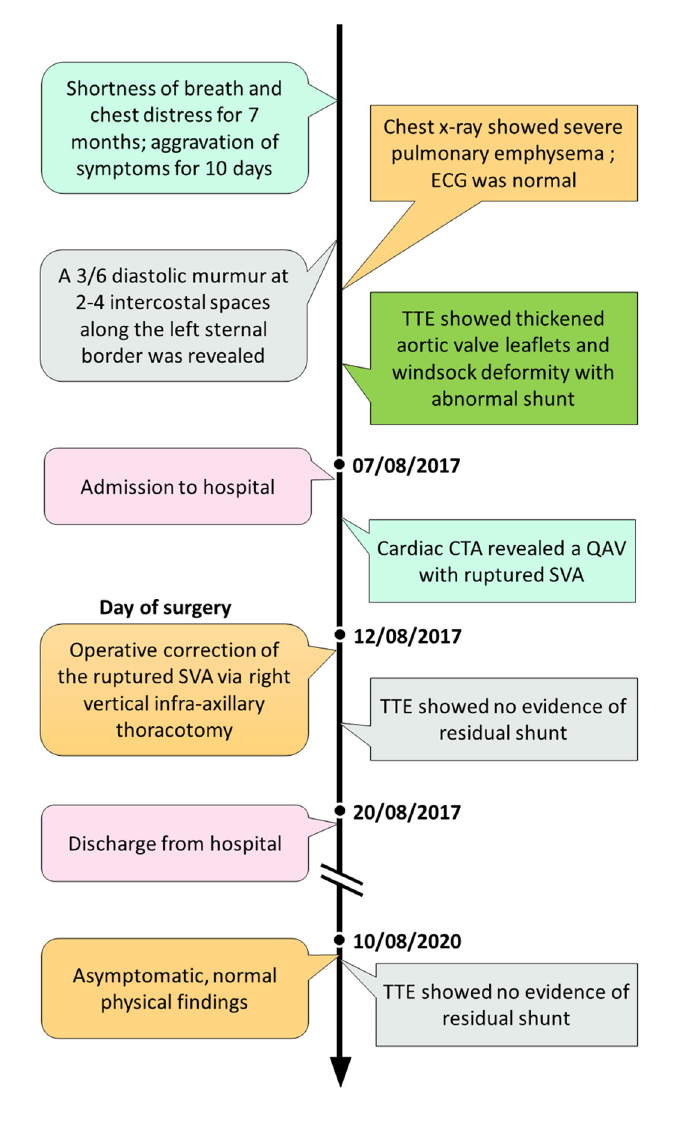
Fig. 3 - Timeline of the diagnosis and treatment process in the present case. CTA=computed tomography angiography; ECG=electrocardiography; QAV=quadricuspid aortic valve; SVA=sinus of Valsalva aneurysm; TTE=transthoracic